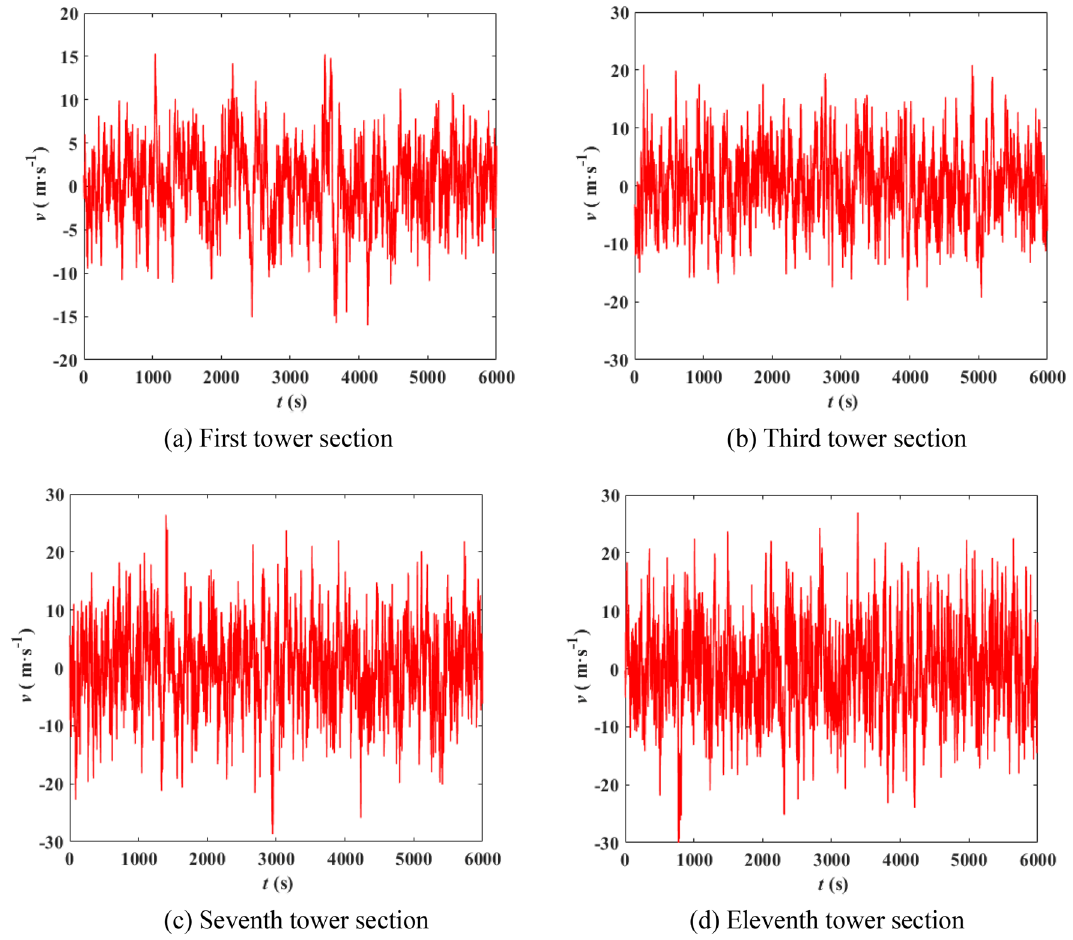
Figure 8. Time history simulation of fluctuating wind speed in typical section of